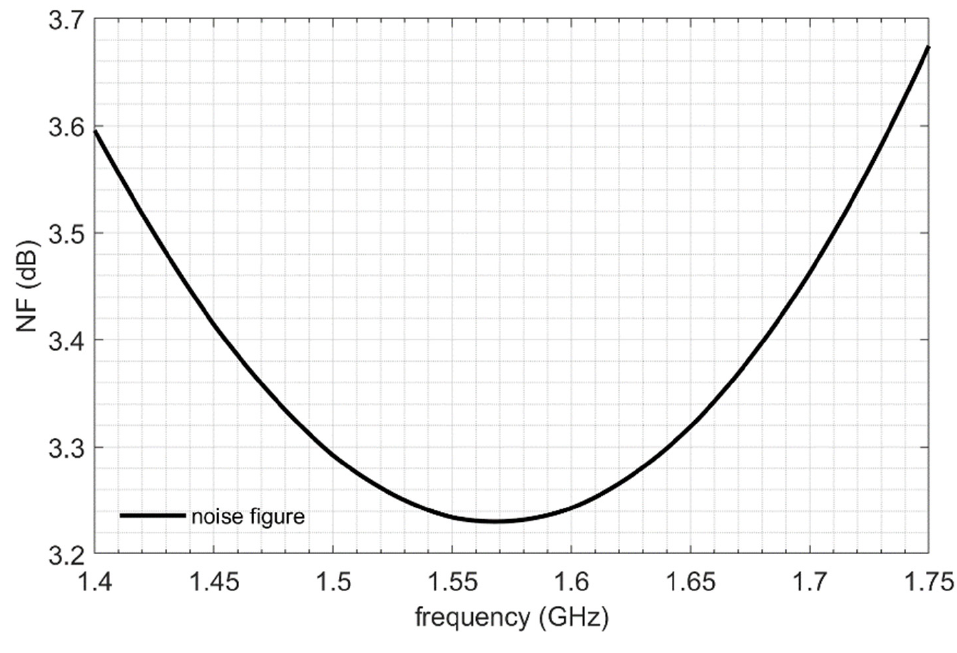
Figure 11. Noise figure of the balun.